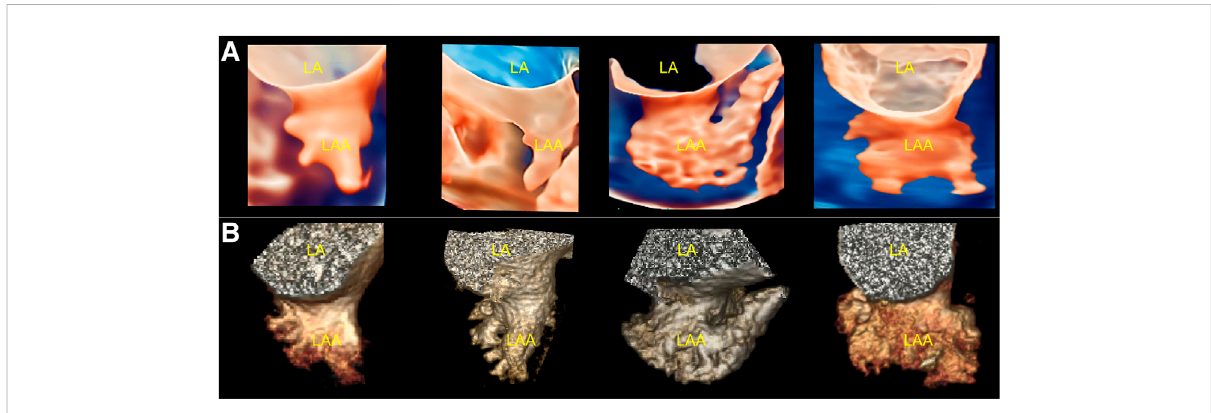
FIGURE 3 Comparison of TrueVue Glass and CCTA for displaying different morphologies of LAA. (A) . From left to right, TrueVue Glass shows cactus, windsock,chicken-wing,andcauli fl owertypeofLAA (B) .Fromlefttoright,CCTAdisplayoftheabovemorphologicaltypes ofLAAareshown. CCTA, cardiac computed tomographic angiography; LA, left atrium; LAA, left atrium